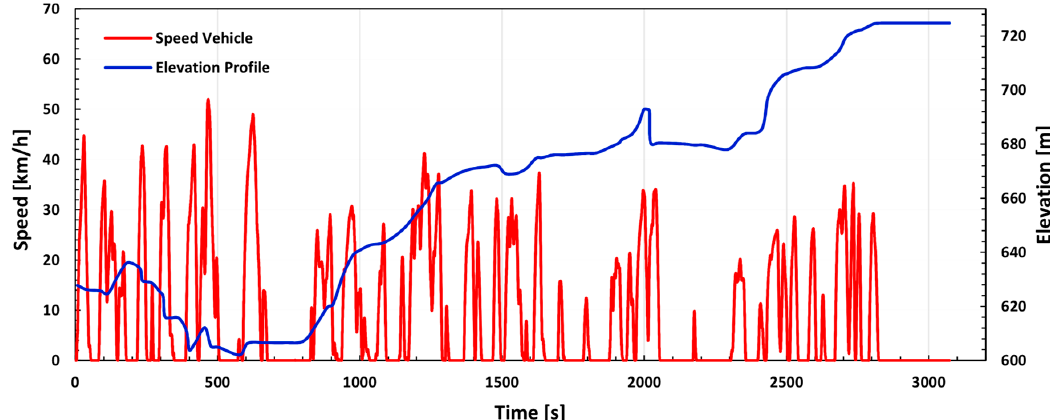
Figure 3. Actual speed and height profiles for a typical result along route 1.